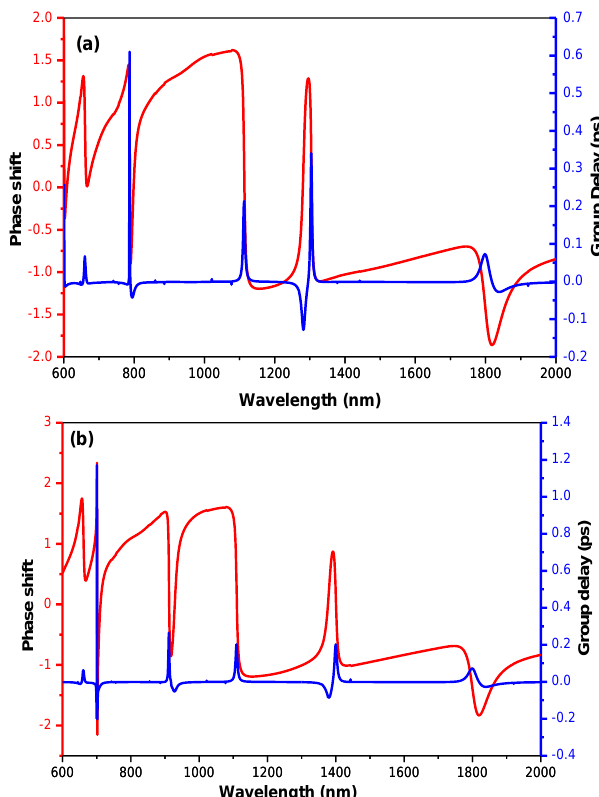
Figure 8. ( a ) The phase shifts with respect to the wavelength of the circular extended structure (red line) and the group delays calculated from the phase shifts (blue line). ( b ) The phase shifts with respect to the wavelength of the ring extended structure (red line) and the group delays calculated from the phase shifts (blue line).